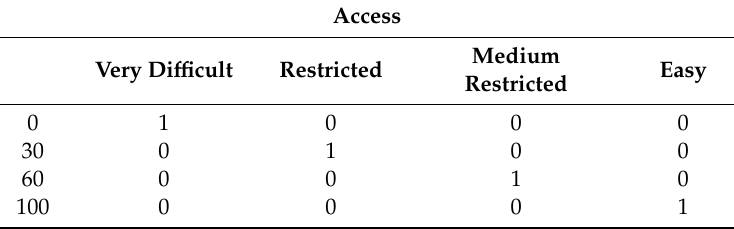
Table 4. Rules database for “access”.